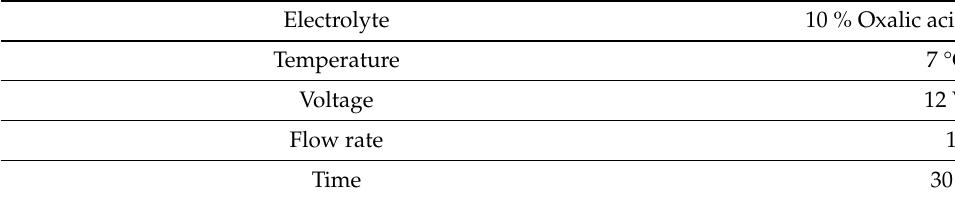
Figure 3. Cuts for longitudinal grindings. Table 2. Parameters for electrolytic